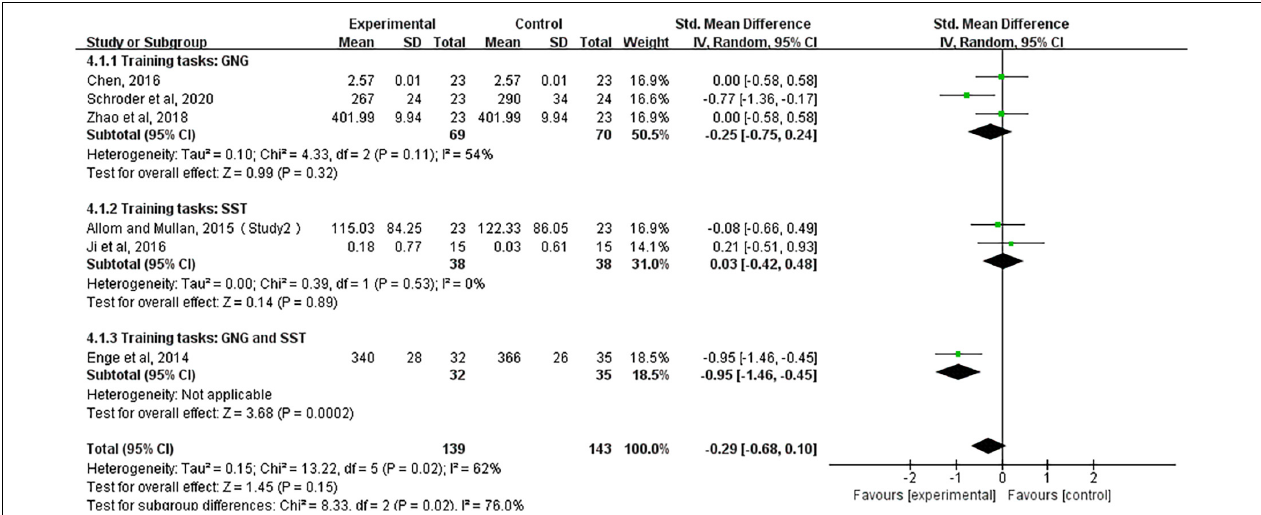
FIGURE 5 | Long-term follow-up effects after training, based on subgroup analysis forest plots for different training tasks (e.g., GNG, Go/no-go tasks; SST, stop-signal tasks; GNG and SST, Go/no-go tasks and stop-signal